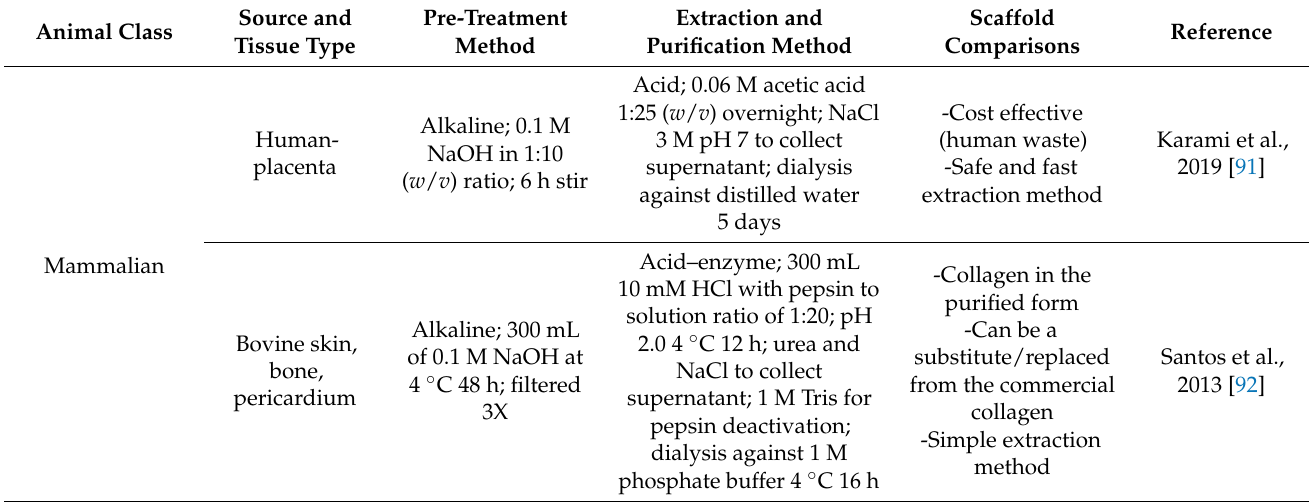
Table 1. Some extraction procedures used for collagen type I from different